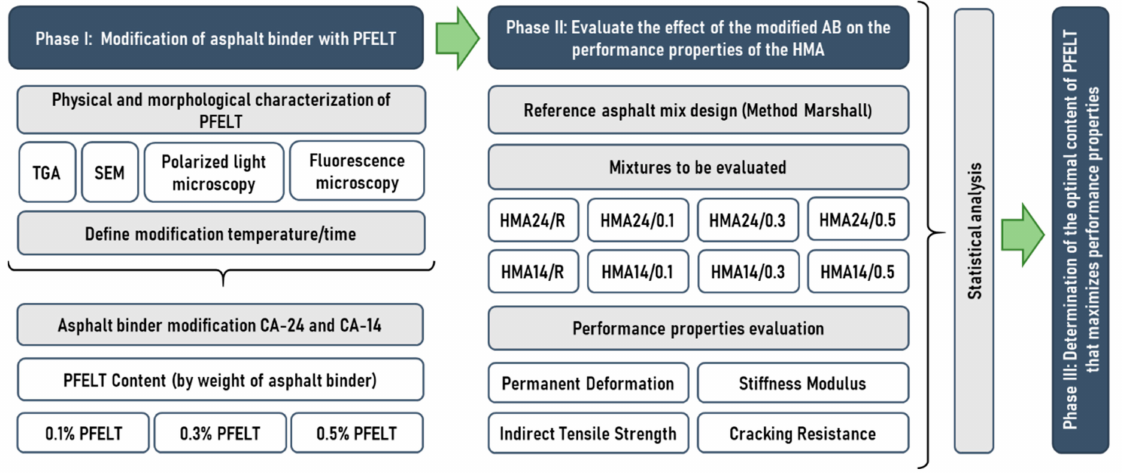
Figure 3. Research